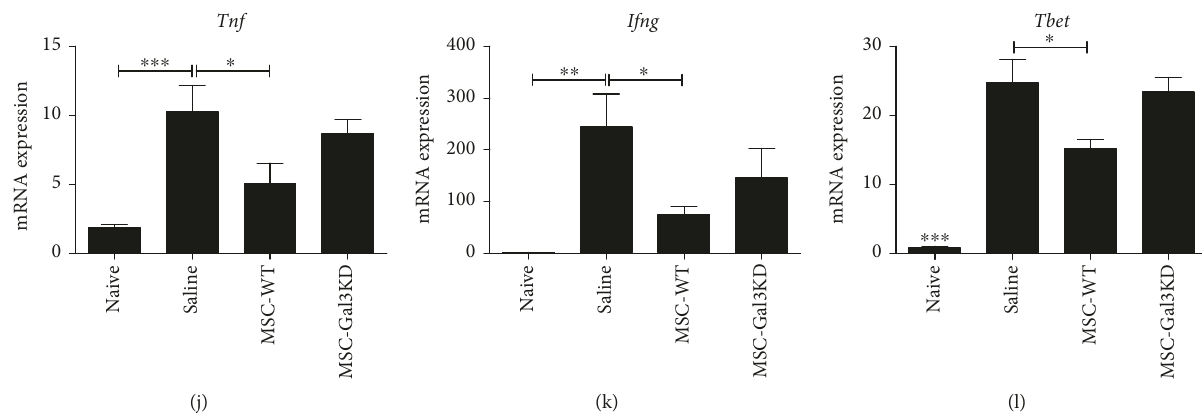
Figure 5: E ff ects of the transplantation of MSC lines in a mouse model of chronic T. cruzi infection. (a) Study design. (b) Cell migration and homing to spleens and hearts were evaluated by ampli fi cation of GFP mRNA by qRT-PCR. (c – f) Representative images of H&E stained heart sections of naïve mice (c), infected and administered with saline (d), MSC-WT (e), or MSC-Gal3KD (f). Quanti fi cation of mRNA expression levels of CD45 coding gene (PTPRC), evaluated qRT-PCR (g). RTqPCR analysis of gene expression in the heart tissue of the cytokines IL1-